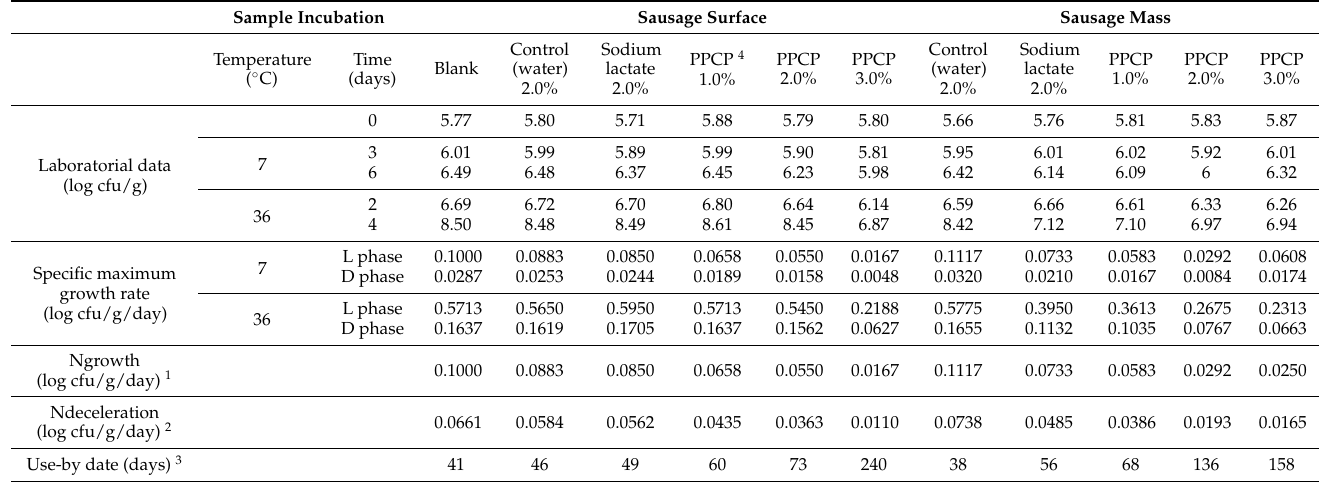
Table 5. Durability study of vacuum-packaged cooked sausages stored at 7 ◦